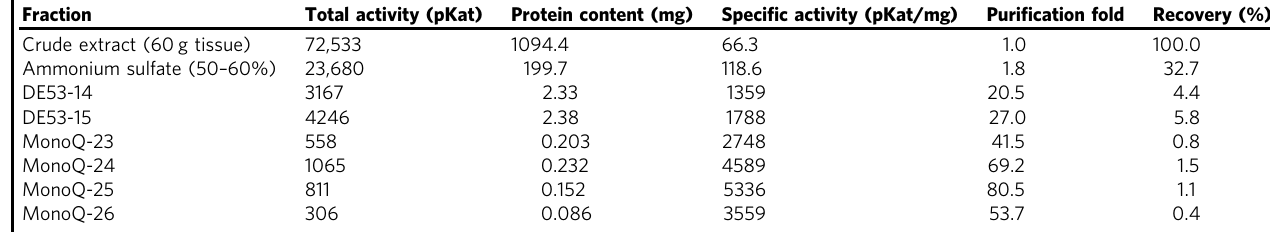
Table 2 PhBS puri fi cation from petunia